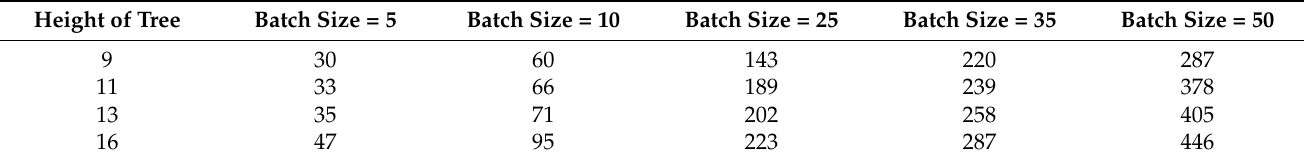
Table 3. Size (MB) of proving key, where the input arithmetic circuit is generated by Algorithm 4 Build ZK-Rollup Circuit.